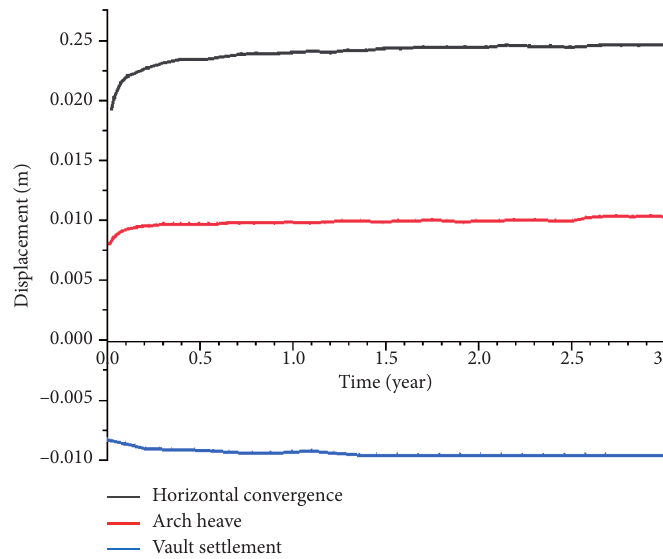
Figure 9: Tunnel second lining displacement-time curve. The diameter of anchor rod is 25 mm the length is 5 m